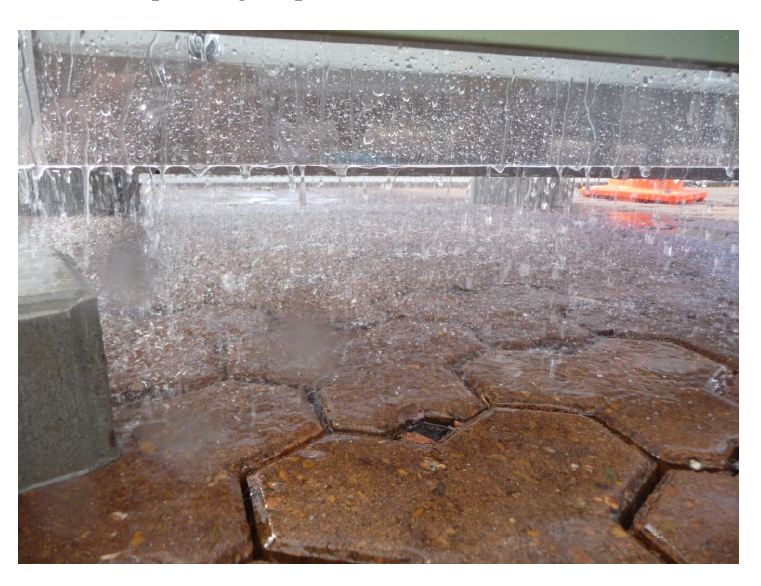
Figure 5. Water ponding on pavement surface under rainfall simulator.